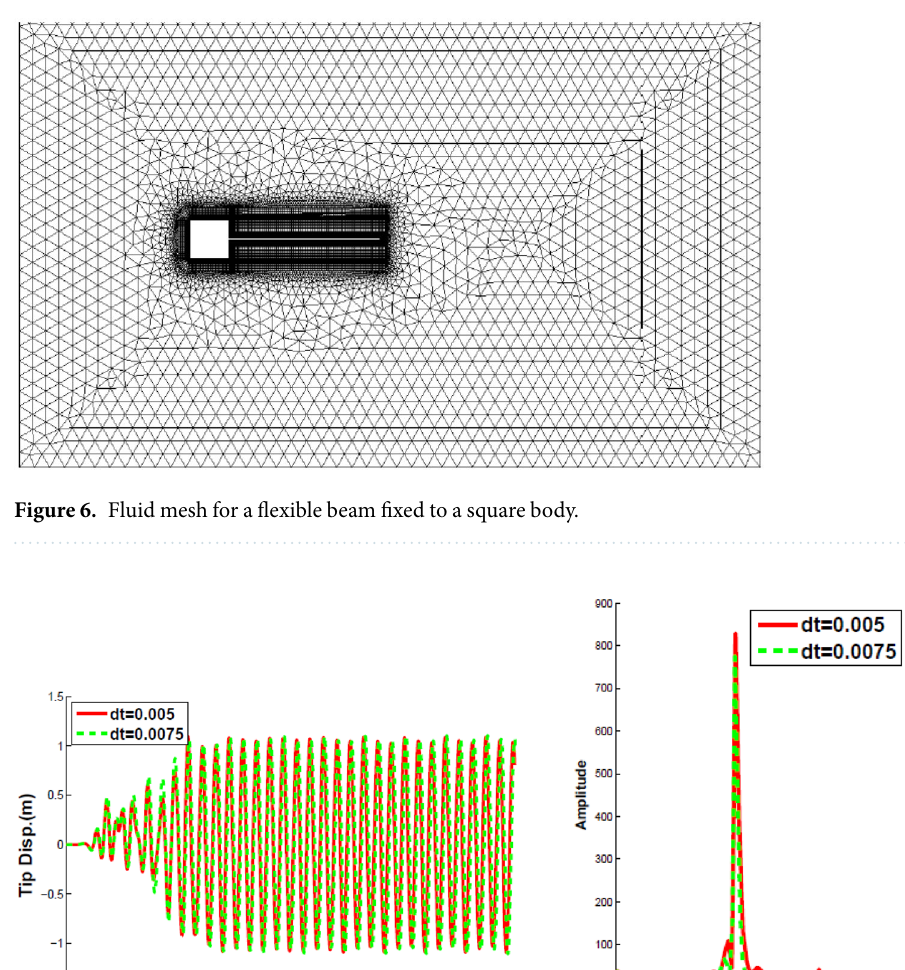
quadrilateral elements were generated in the boundary layers and triangular elements are generated for the rest. The number of total points was 18984 and the number of total cells was 23872. The flexible beam was modeled by geometrically exact beam and discretized into 41 nodes and 40 finite element cells. The FSI problem was solved with dynamic Aitken’s relaxation besides using the second-order predictor to estimate the interface displacements. The Aitken relaxation technique was used with an initial value of 0.5, which rapidly increased to the range of values from 0.8 to 1.0. The convergence tolerance of the interface displacement residual, which is depicted as TOL in Algorithm 3, is set to − 10 7 . The comparisons of the displacement at the free end of the beam and corresponding Fourier analysis at the time steps Δ t 1 = 0.005 s and Δ t 2 = 0.0075 s are plotted in Fig. 7. The following observations were made from the Fig. 7. The deviation of the responses obtained for Δ t 1 and